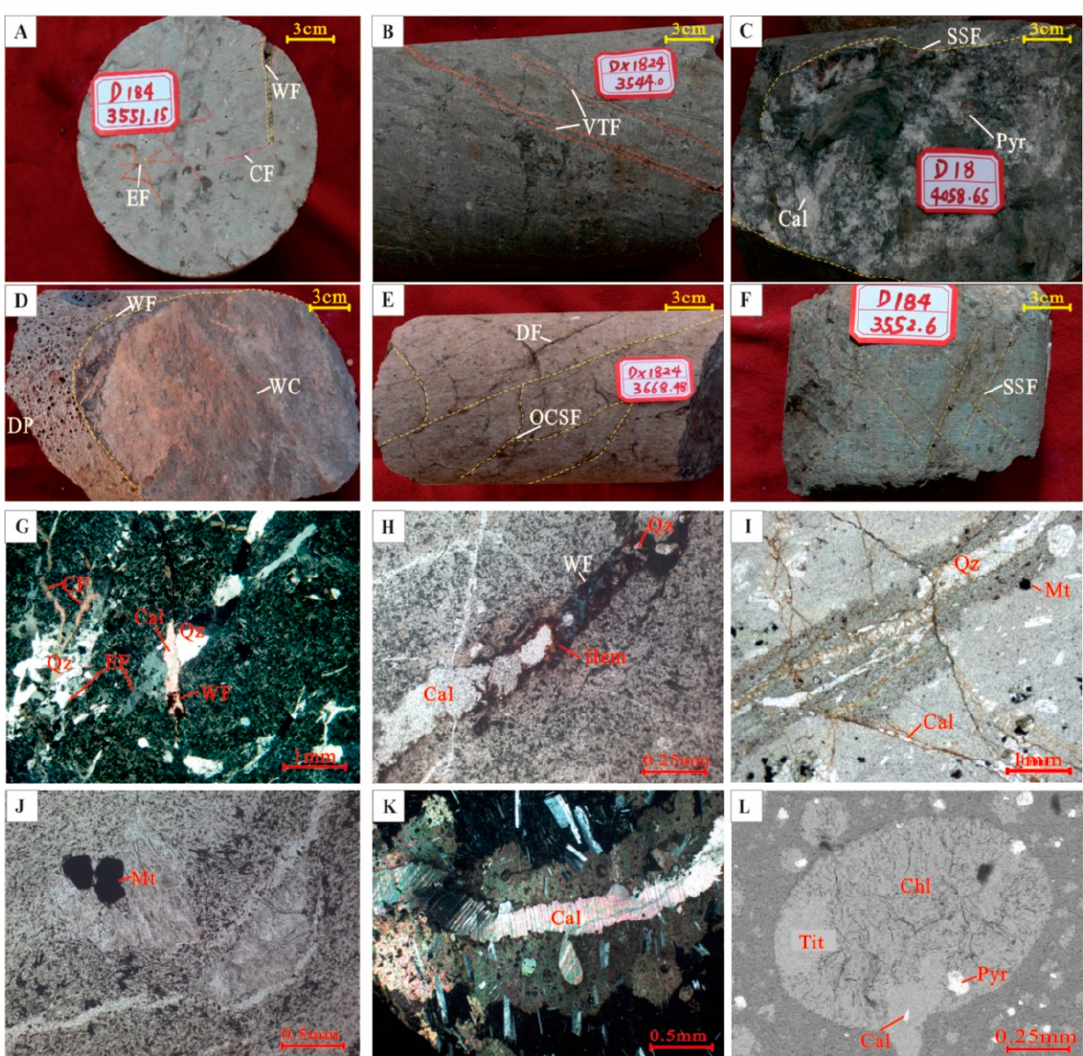
Figure 4. Macro photographs and photomicrographs of fracture fillings and alteration haloes from the Carboniferous Batamayineishan Formation, Dixi Area. ( A ) Multiple genetic fractures (WF, CF, EF) in andesite superimposed into irregular net, core picture; ( B ) vertical tension fractures (VTF) in andesite are completely filled with quartz, color on both sides of fissure is clearly darker than the surrounding rock, core picture; ( C ) fractures (SSF) of volcanic breccia filled with calcite and idiomorphic granular pyrite, core picture; ( D ) weathered fractures of orthophyre filled with red weathered clay (WC), dissolution pores (DP) are developed, core picture; ( E ) Oblique crossing structural fracture (OCSF) and dissolution fracture (DF) of orthophyre, core picture; ( F ) shear structural fracture (SSF) in andesite are completely filled with calcite, core picture; ( G ) fractures in veins and branches cutting the rock into brecciated structure; time of formation of quartz vein is earlier than that of calcite vein, (+); ( H ) weathered fractures filled with red weathered clay, vadose silt and sparry calcite, (+); ( I ) quartz vein formed due to activity of hydrothermal fluid is cut by later structural fractures, which are filled with calcite, ( − ); ( J ) fractures bypass phenocryst, Ti-bearing magnetite (Mt) with relatively good degree of idiomorphism is seen in the surrounding rock to the fracture, ( − ); ( K ) fractures filled with calcite; two sides of alteration haloes along the fractures are distributed with matrix minerals and pore voids, (+); ( L ) pores filled with chlorite, sphene and pyrite, (backscattered electron image). Cal = calcite; Pyr = pyrite; Qz = quartz; Hem = hematite; Mt = ilmenite; Tit = titanite; Chl = chlorite; ( − ) = plane polarized light; + = cross polarized light.